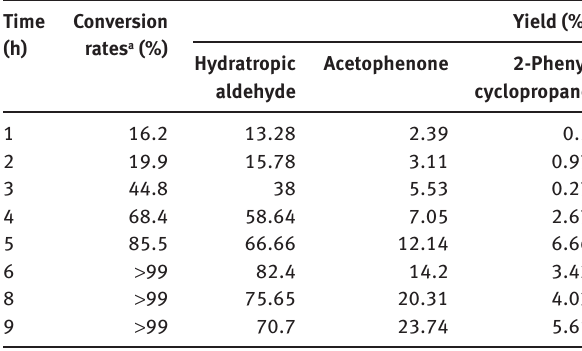
Table 3: The influence of the reaction time.